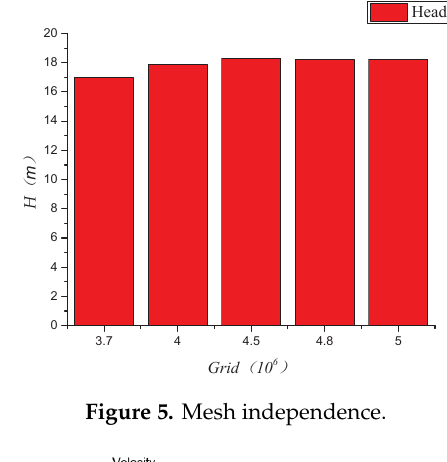
Figure 4. Partial mesh view of the flow domain: ( a ) inlet pipe, ( b ) side channel, ( c ) impeller and gaps.